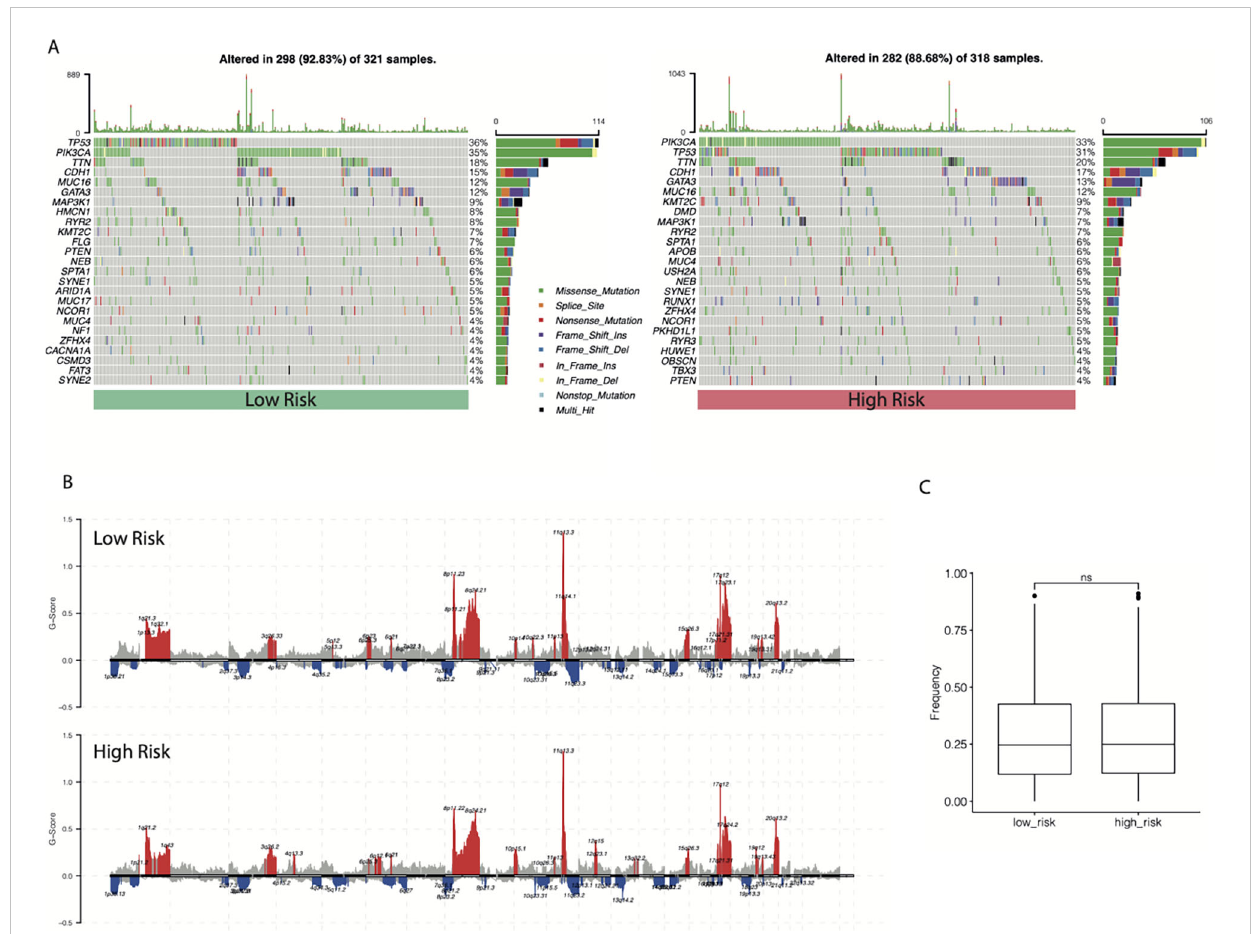
FIGURE 11 The landscape of SNV and CNV between different cr-TILCD8TSig subgroups. (A) Top 25 signi fi cantly mutated genes were illustrated in the two subgroups. (B) Comparison of signi fi cant copy number ampli fi cations and deletions between the two subgroups. (C) Comparison of the proportion of fragments with signi fi cant copy number variation to the entire